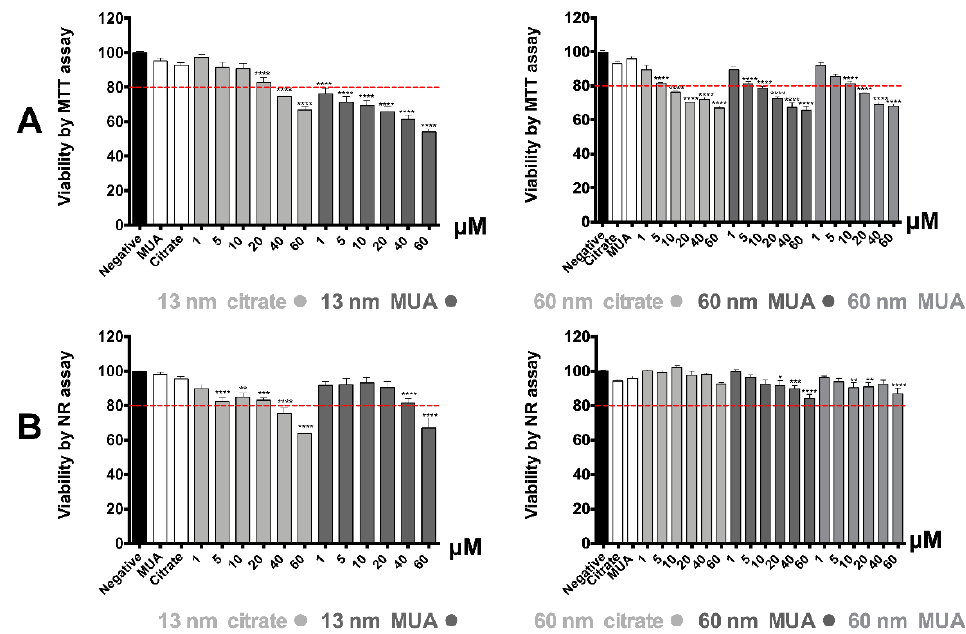
Figure 2. Cytotoxicity elicited by the AuNPs in HK-2 cells. Data obtained in the ( A )